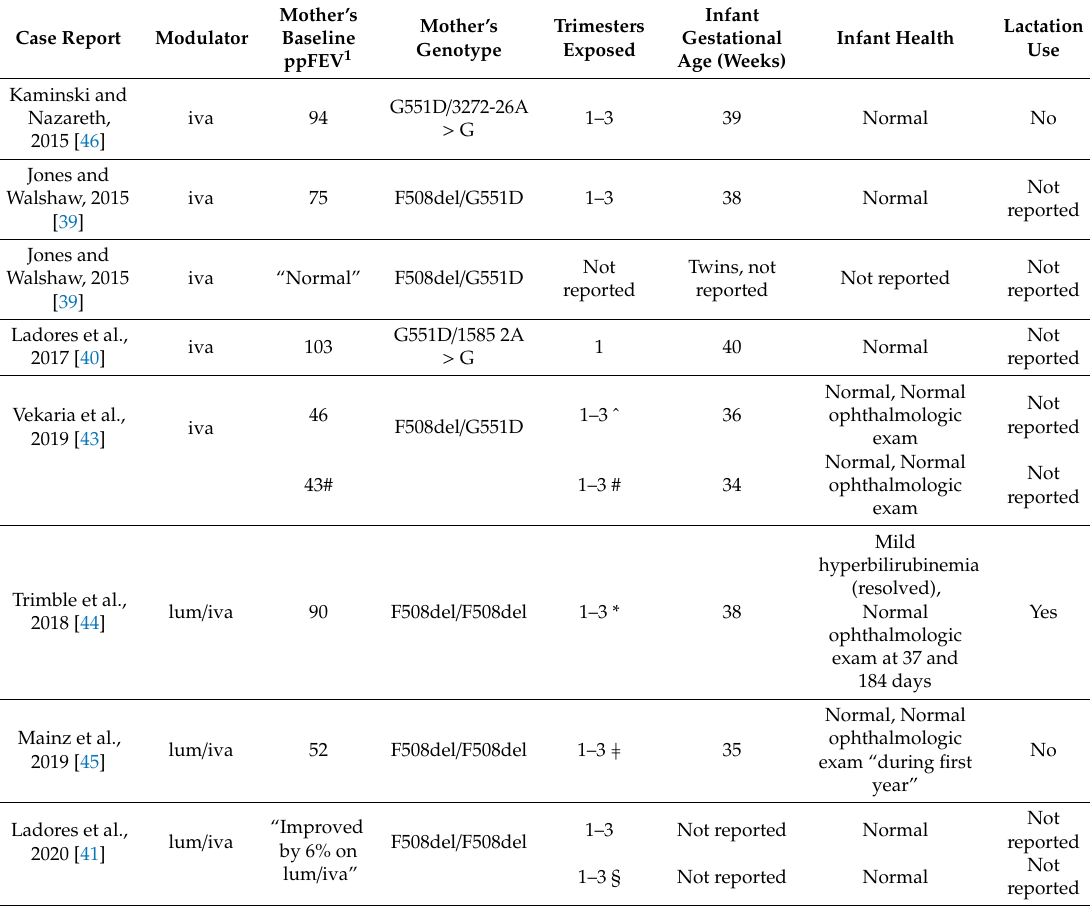
Table 2. Case reports of modulators and